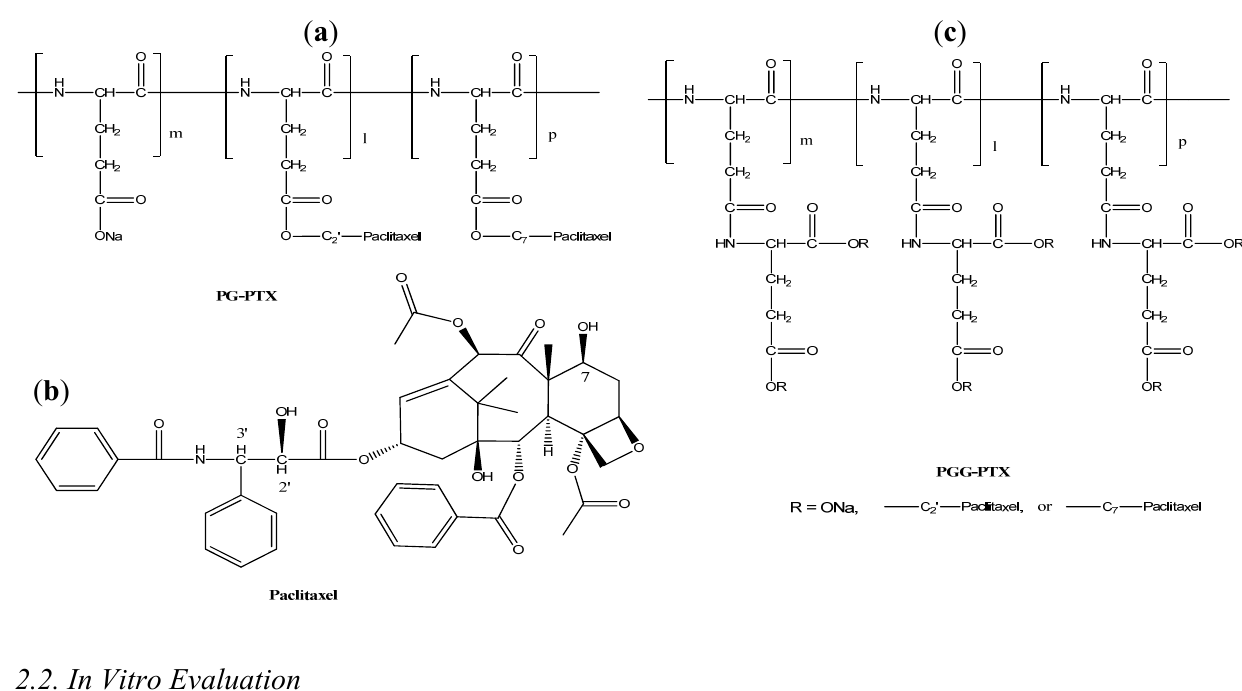
Figure 3. Structure of PG-PTX ( a ), paclitaxel ( b ), and PGG-PTX ( c